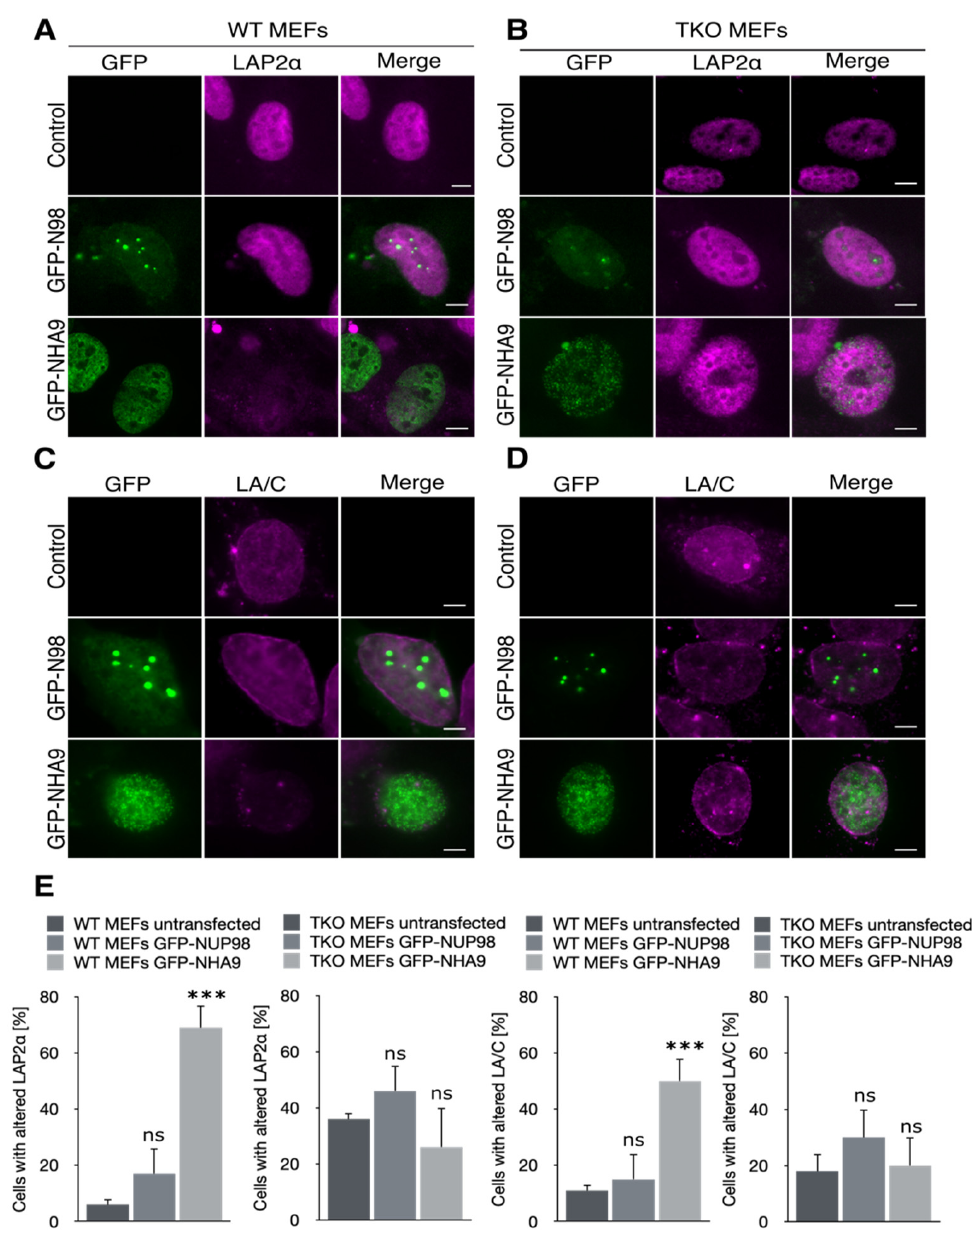
Figure 1. NUP98–HOXA9 perturbs LAP2 α and lamin A/C distribution in MEFs. Wildtype and RB triple knockout (TKO) mouse embryonic fibroblasts (MEFs) were transiently transfected with the indicated GFP constructs, fixed, and stained for immunofluorescence microscopy 48 h post-transfection. ( A ) In MEFs expressing GFP-NUP98–HOXA (GFP-NHA9, green), LAP2 α (magenta) intensity was diminished in the nucleoplasm, ( B ) while in TKO MEFs LAP2 α intensity was similar to the control and GFP-NUP98 (GFP-N98, green) expressing cells. ( C ) GFP-NHA9 (green) expression in MEFs caused a reduced intensity of LA/C (magenta) at the NE, ( D ) but not in TKO MEFs. Shown are representative confocal images. Scale bars, 5 μ m. ( E ) Quantification of cells with altered LAP2 α and LA/C distribution. Total number of analyzed cells is indicated at the bottom of each bar. The number of experiments for LAP2 α staining was: n = 4; number of experiments for LA/C staining were: n = 3; *** p < 0.01, ns, p not significant, t -test, two-tailed, normalized to untransfected MEFs.